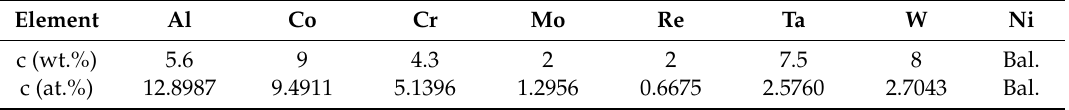
Table 2. Equilibrium phase concentration c i ,eq α and di ff usion coe ffi cient D i α of DD6 at 1120 ◦